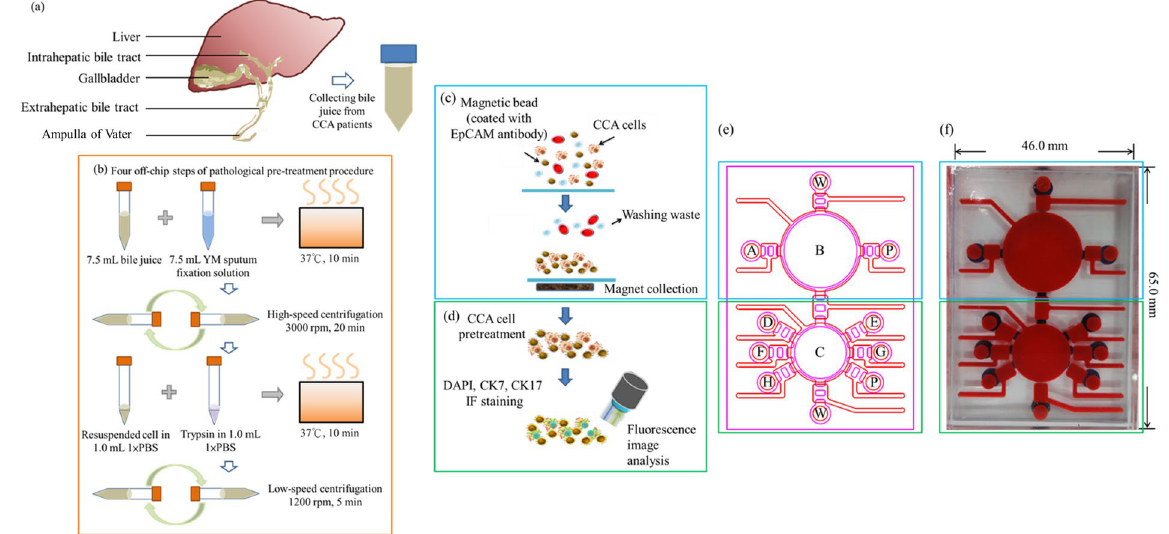
Figure 1. ( a ) Illustration of the relative positions of the liver, gallbladder, and biliary tree. ( b ) The working process of the four off-chip pre-treatment steps for preparation of bile. ( c ) Illustration of on-chip cholangiocarcinoma (CCA) cell capture, washing, and collection. ( d ) Illustration of on-chip immunofluorescence (IF) staining and analysis. Please see the main text for full names of the molecular probes/antibodies. ( e ) The integrated microfluidic chip equipped with the following micro-devices: A = sample loading chamber, B and C = membrane- type micromixers/micropumps, D = 4% paraformaldehyde chamber, E = 0.1% Triton X 100 chamber, F = first antibody chamber, G = secondary antibody chamber, H = DAPI/Hoechst stain chamber, P = PBS (1x) chamber, and W = waste outlet; ( f ) A photograph of the chip. The red ink indicates the air control layer, and the blue ink represents fluid channel